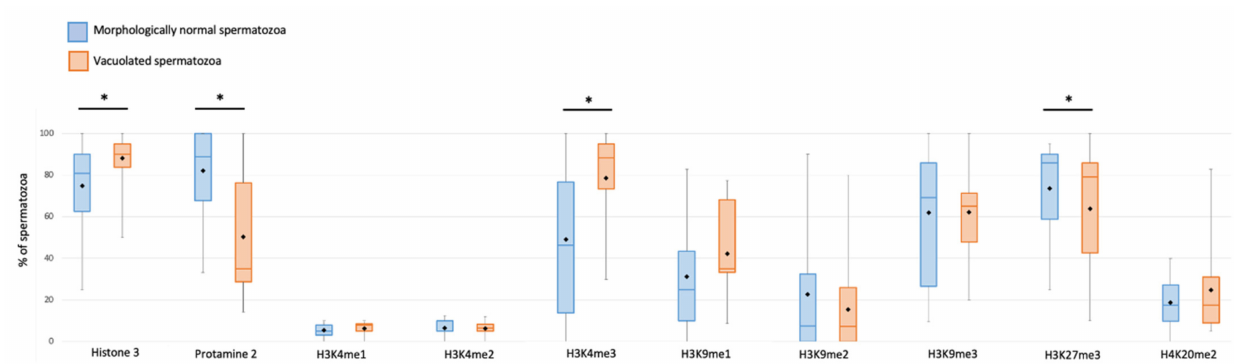
Figure 4. Percentage of non-vacuolated spermatozoa (blue box) and vacuolated spermatozoa (orange box) positively targeted for each of the ten epigenetic marks evaluated. Boxes represent data included in third and first interquartile range (Q3–Q1), horizontal bars represent median, and black squares represent mean. Whiskers represent upper (95%) and lower (5%) confidence intervals. Asterisks indicate significative differences among vacuolated and non-vacuolated spermatozoa ( p <